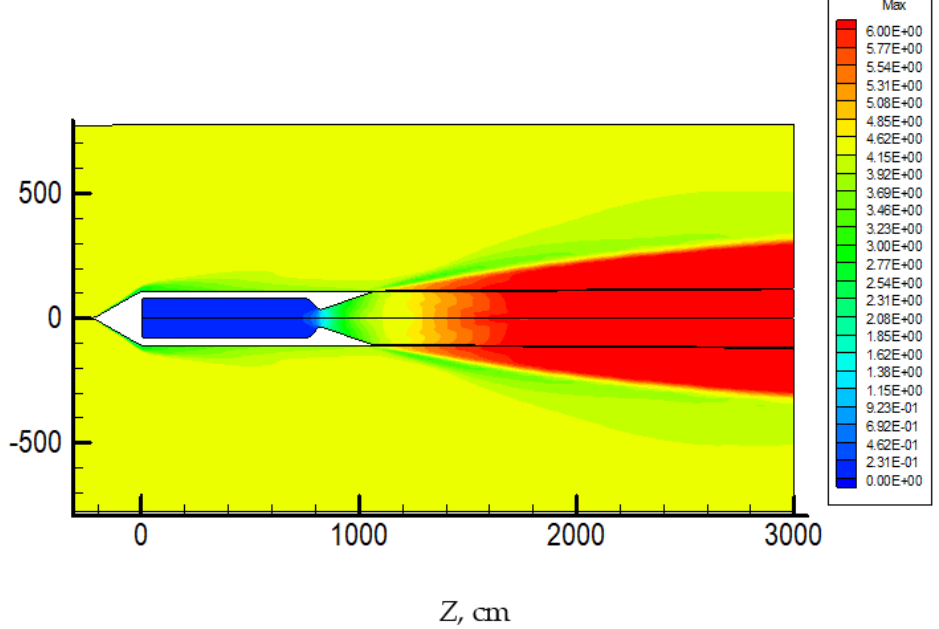
Figure 5. Spatial distribution of Mach number M in the combustion products and the down jet ( h = 55 km, n ≈ 80, M = 4.4, and T ∞ = 270